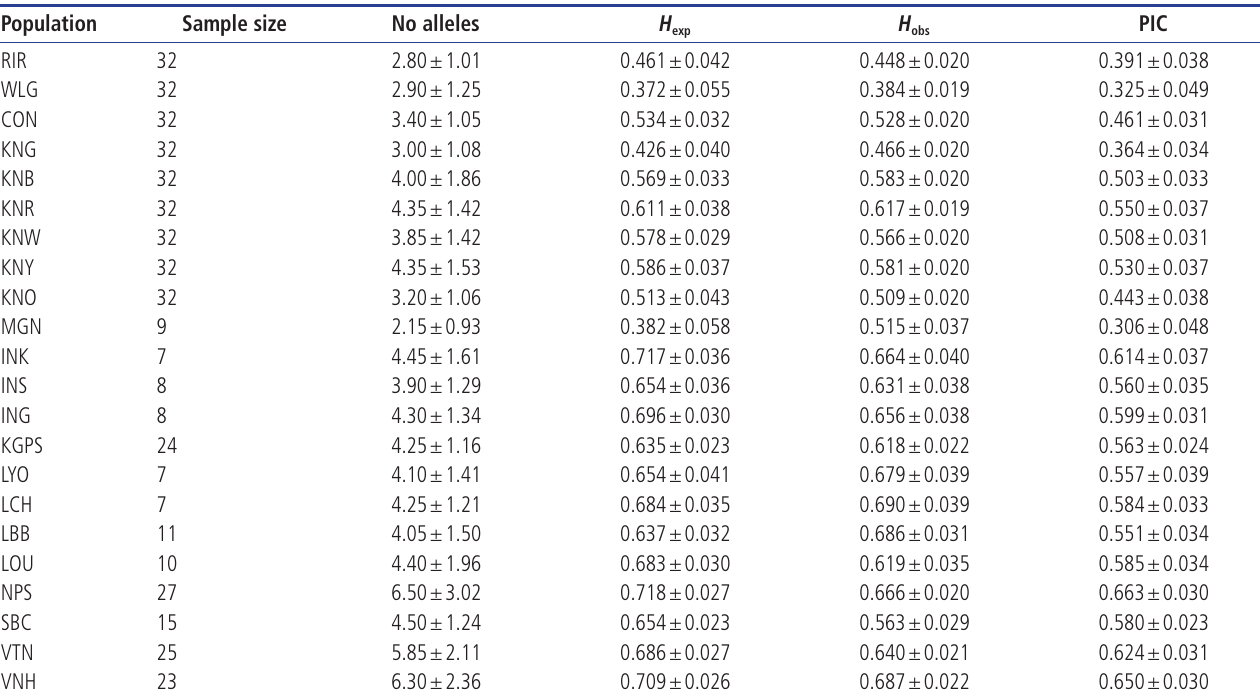
Table 3. Genetic diversity parameters in 22 chicken breeds Population Sample